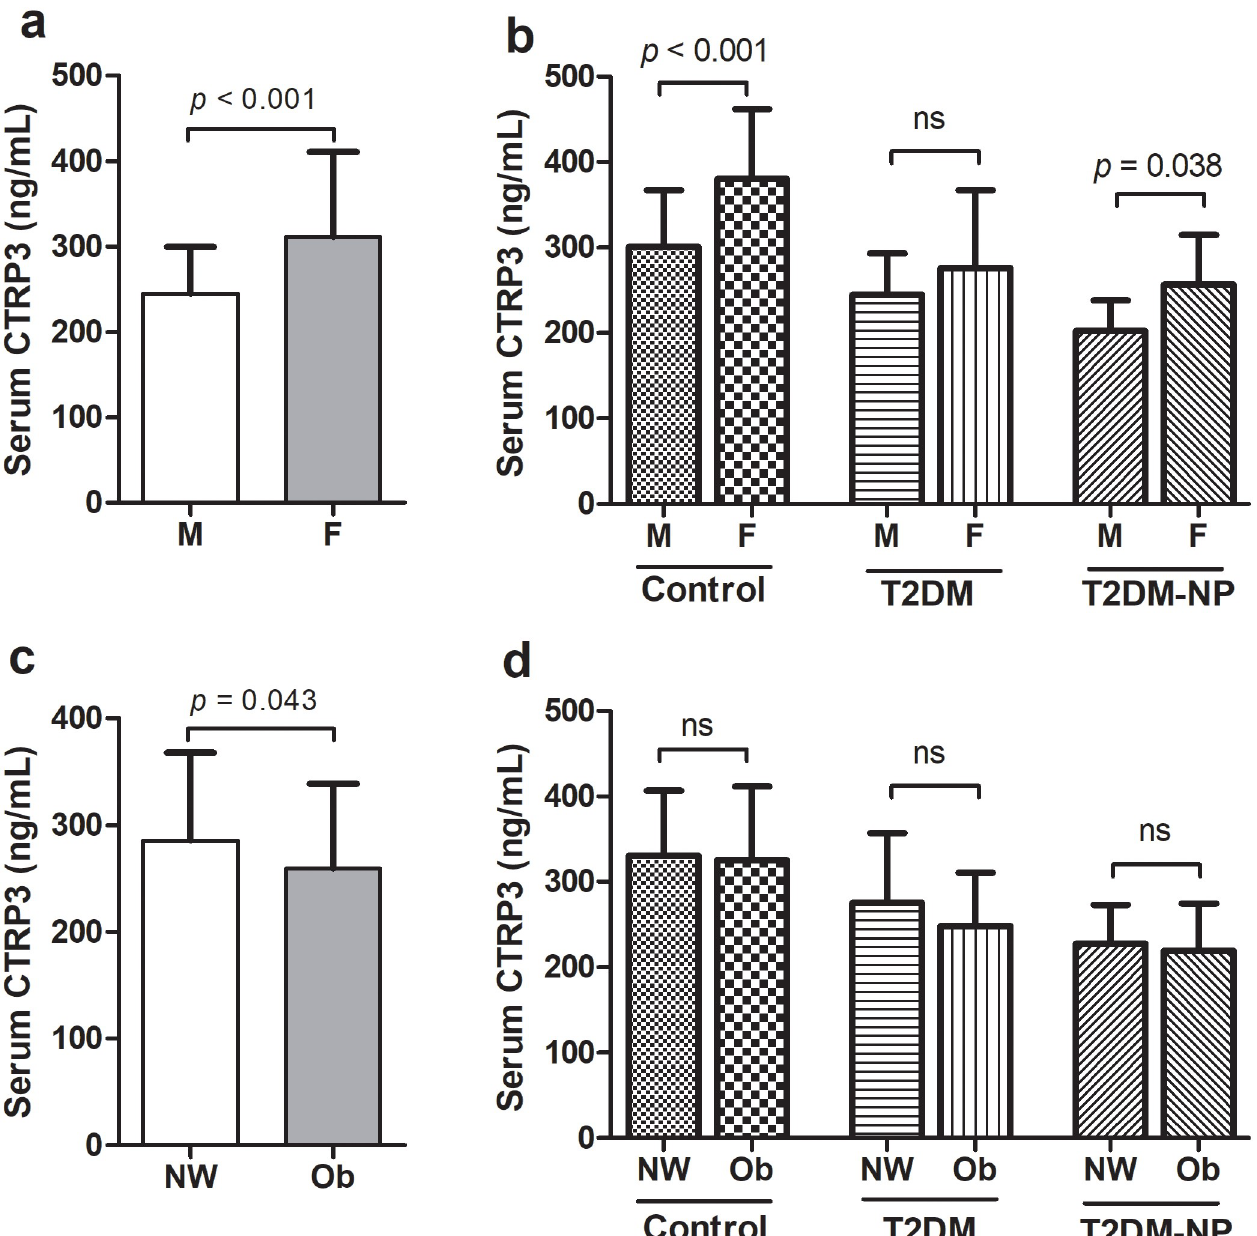
Fig 2. Serum levels of CTRP3 stratified by sex and BMI. a) Serum levels of CTRP3 stratified by sex, b) Serum levels of CTRP3 stratified by sex in the each group, c) Serum levels of CTRP3 stratified by BMI and d) Serum levels of CTRP3 stratified by BMI in each group. M: Male, F: Female, NW: Normal weight and Ob: